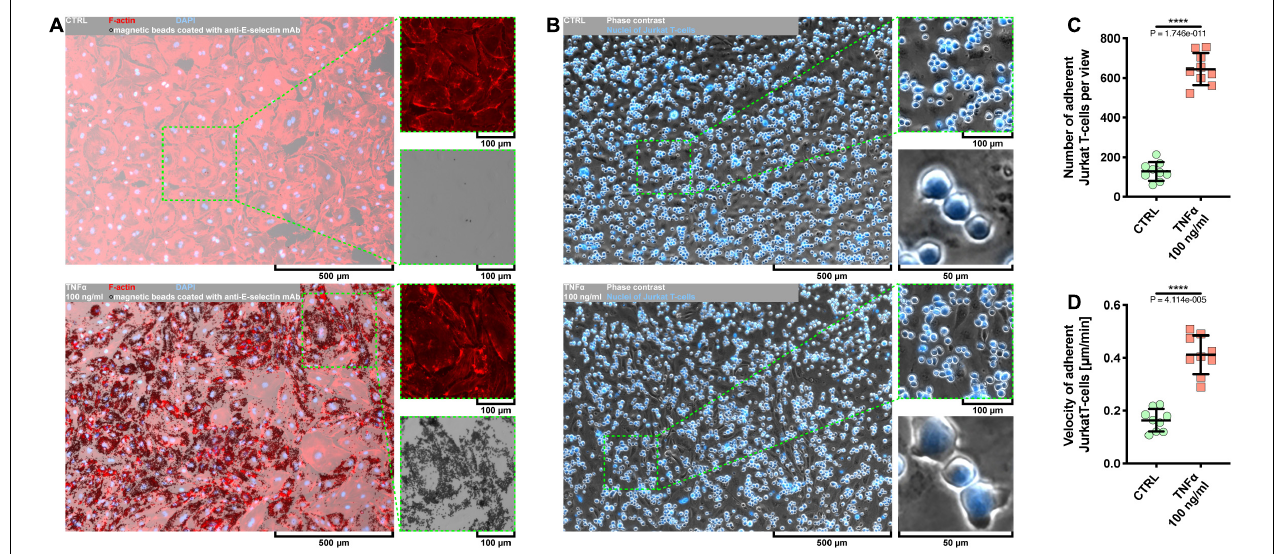
FIGURE 1 | Effect of TNF α on activation of pHCAECs. (A) Representative micrographs of intravital detection of E-selectin using magnetic beads coated with anti-E-selectin monoclonal antibodies (bright field). F-actin (red) and nuclei (blue) were stained fluorescently after fixation. CTRL refers to the control (top panel), TNF α 100 ng/ml to cells treated with rh TNF α (bottom panel), mAb to monoclonal antibodies. (B) Representative micrographs of intravital co-culture of pHCAECs (contrast phase) with Jurkat T cells (contrast phase and fluorescence). Nuclei of Jurkat T cells (blue) were stained with Hoechst 33342. CTRL refers to the control (top panel), TNF α 100 ng/ml to cells treated with rh TNF α (bottom panel). (C) Number of adherent Jurkat T cells to pHCAECs per microscopic field from the control and TNF α -activated pHCAECs after 30 min of their co-culture. CTRL refers to the control (top panel), TNF α 100 ng/ml to cells treated with rh TNF α , **** to p < 0.0001, as determined by unpaired t -test. (D) Velocity of motile Jurkat T cells on pHCAECs during 30 min of their co-culture. CTRL refers to the control (top panel), TNF α 100 ng/ml to cells treated with rh TNF α . **** p < 0.0001, as determined by unpaired t